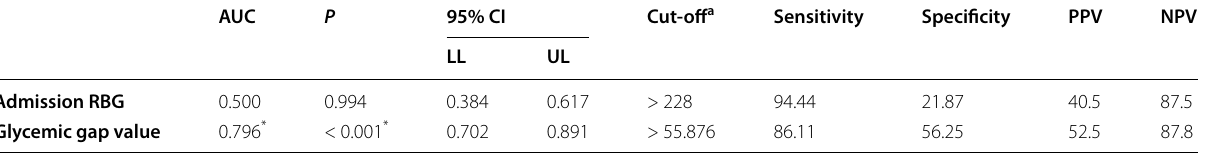
AUC area under a curve, p value probability value, CI confidence intervals, NPV negative predictive value, PPV positive predictive value *Statistically significant at p 0.05 ≤ a Cut-off was choose according to Youden